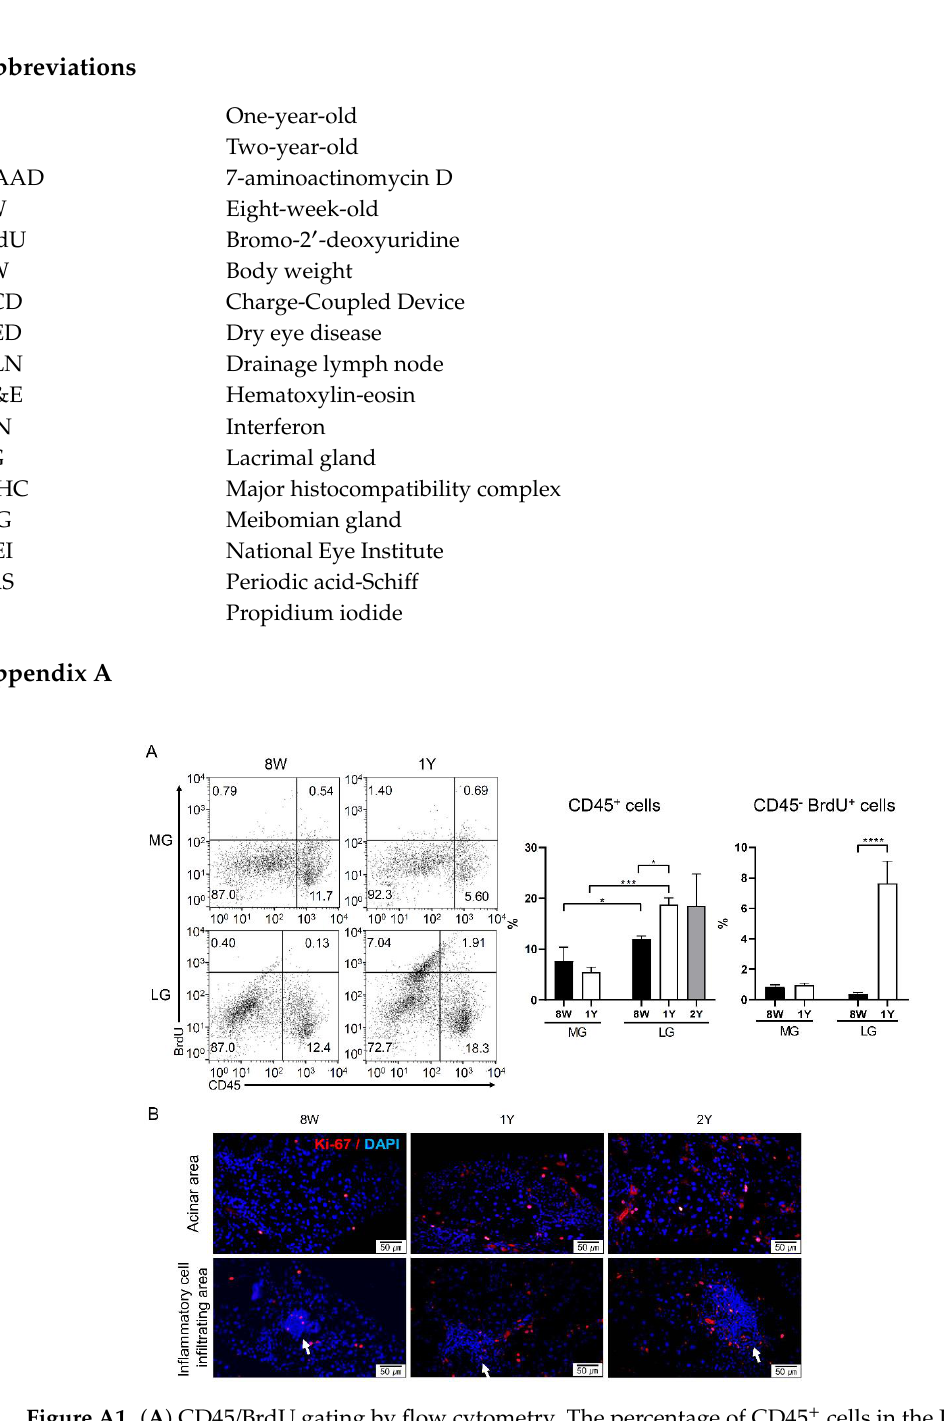
Figure A1. ( A ) CD45 / BrdU gating by flow cytometry. The percentage of CD45 + cells in the LGs was significantly higher in 1Y-old mice than in 8W-old mice ( p = 0.044; one-way ANOVA followed by